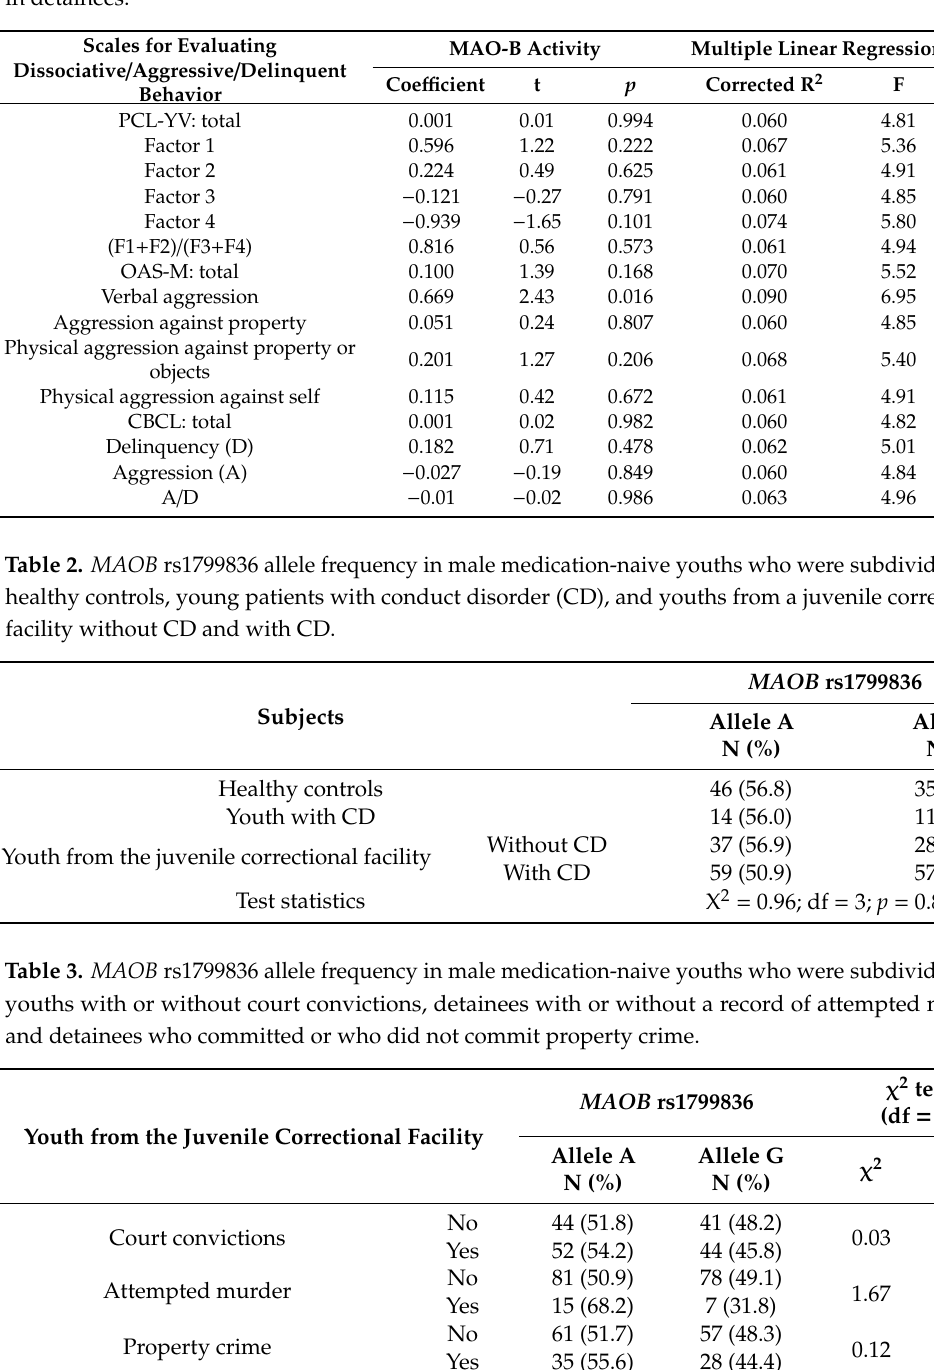
Table 1. Multiple linear regression with platelet MAO-B activity and number of scores of aggressive / dissociative / delinquent behaviors evaluated using Hare Psychopathy Checklist: Youth Version (PCL-YV), Overt Aggression Scale-Modified (OAS-M), and Child Behavior Checklist (CBCL) in detainees.